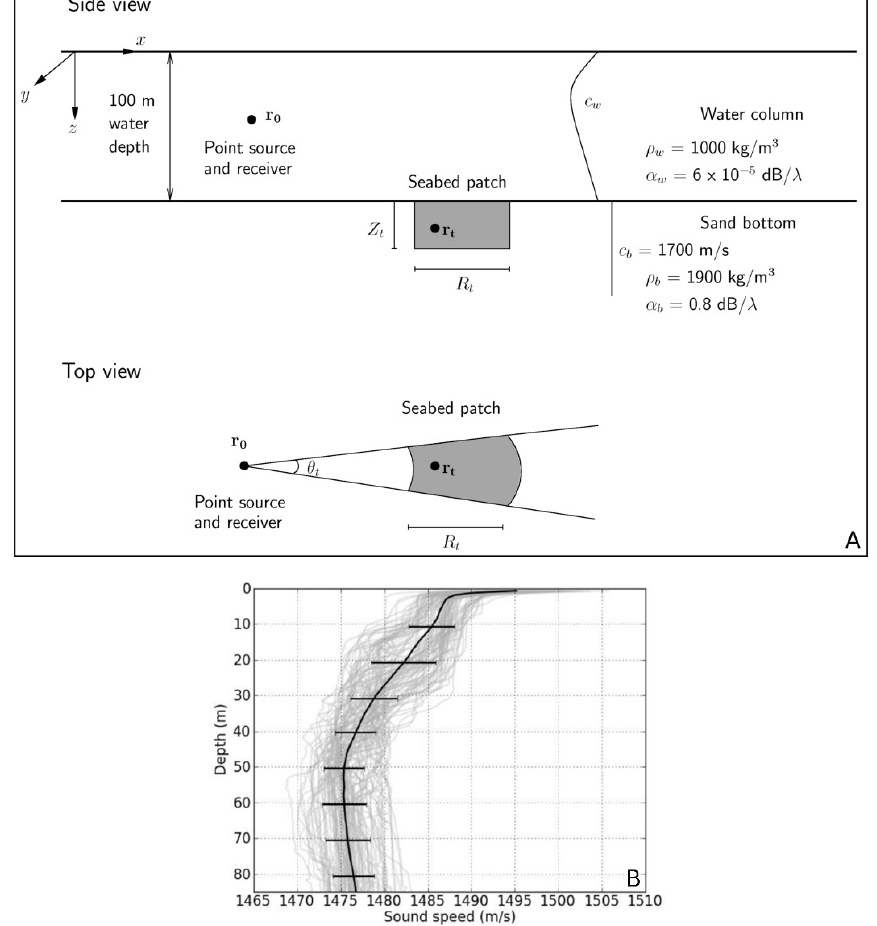
, depth t is used instead [10]. The sound speed, t , ρ , α and c , ρ , w w w b b